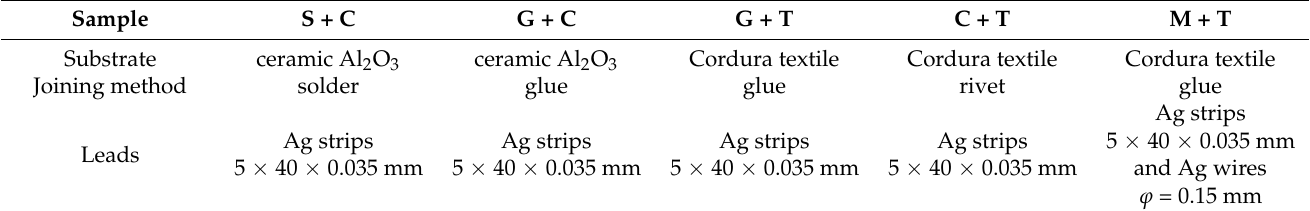
Table 1. Parameters of the